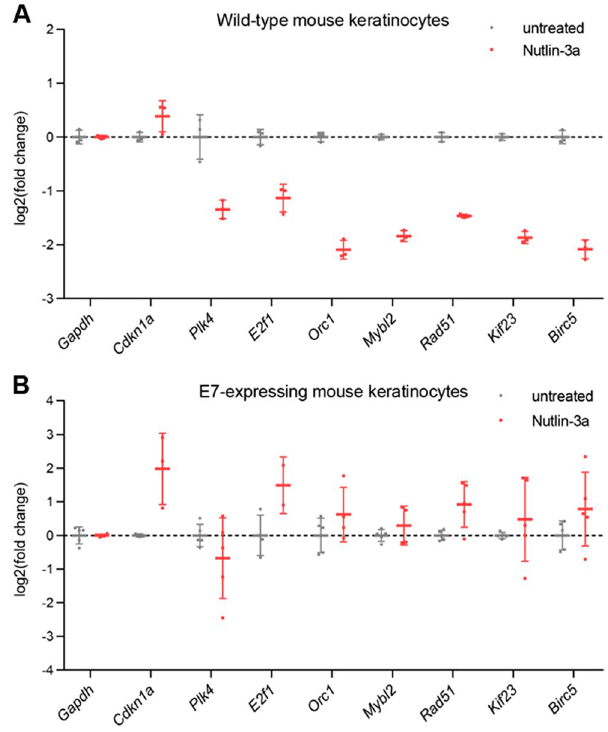
Figure 2. HPV E7 abrogates p53-mediated downregulation of DREAM target genes in wild-type keratinocytes. ( A ) Wild-type mouse keratinocytes were treated with Nutlin-3a for 24 h or left untreated. ( B ) Mouse keratinocytes were co-transfected with plasmids expressing HPV E7 and EGFP and treated with Nutlin-3a for 24 h or left untreated. Cells were sorted for green fluorescence followed by mRNA preparation. Relative mRNA expression was quantified by real-time RT-PCR and normalized to GAPDH RNA levels. The log2-fold change of mRNA expression is displayed for treated compared to untreated